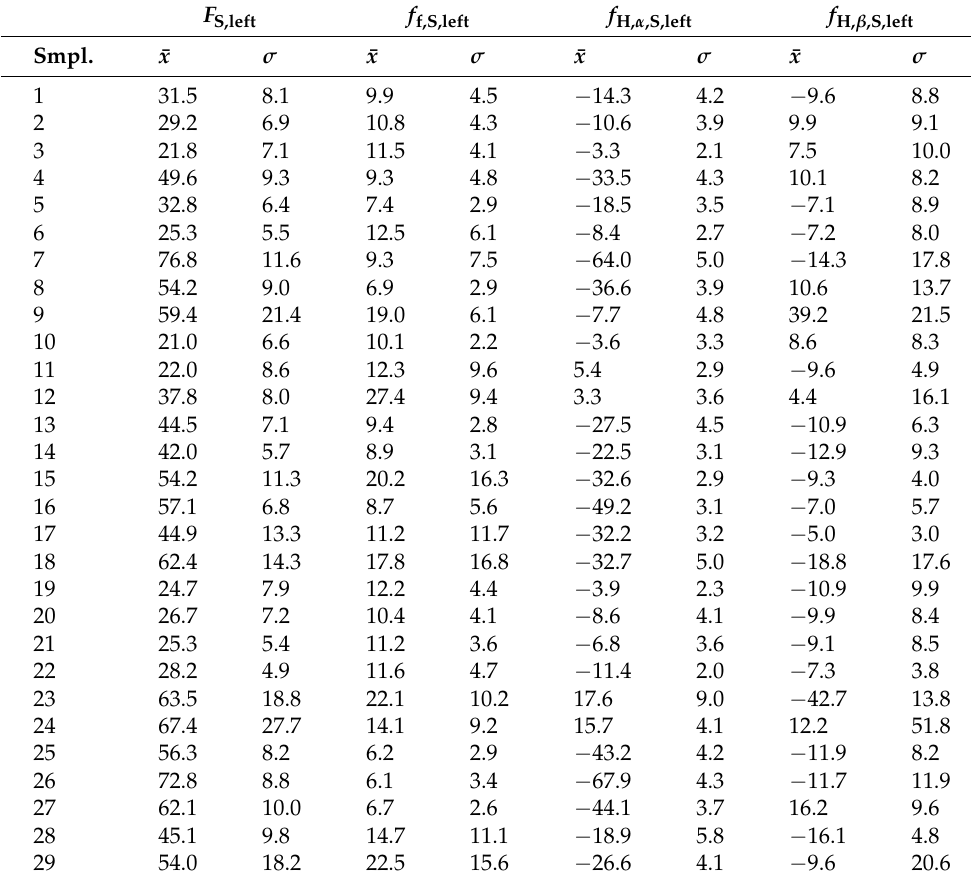
Table A2. Results of the evaluation of areal parameters for gear metrology. The arithmetic mean and the standard deviation of the parameter on all of the teeth. F S,left f f,S,left f H, α ,S,left f H, β ,S,left Smpl. ¯ x